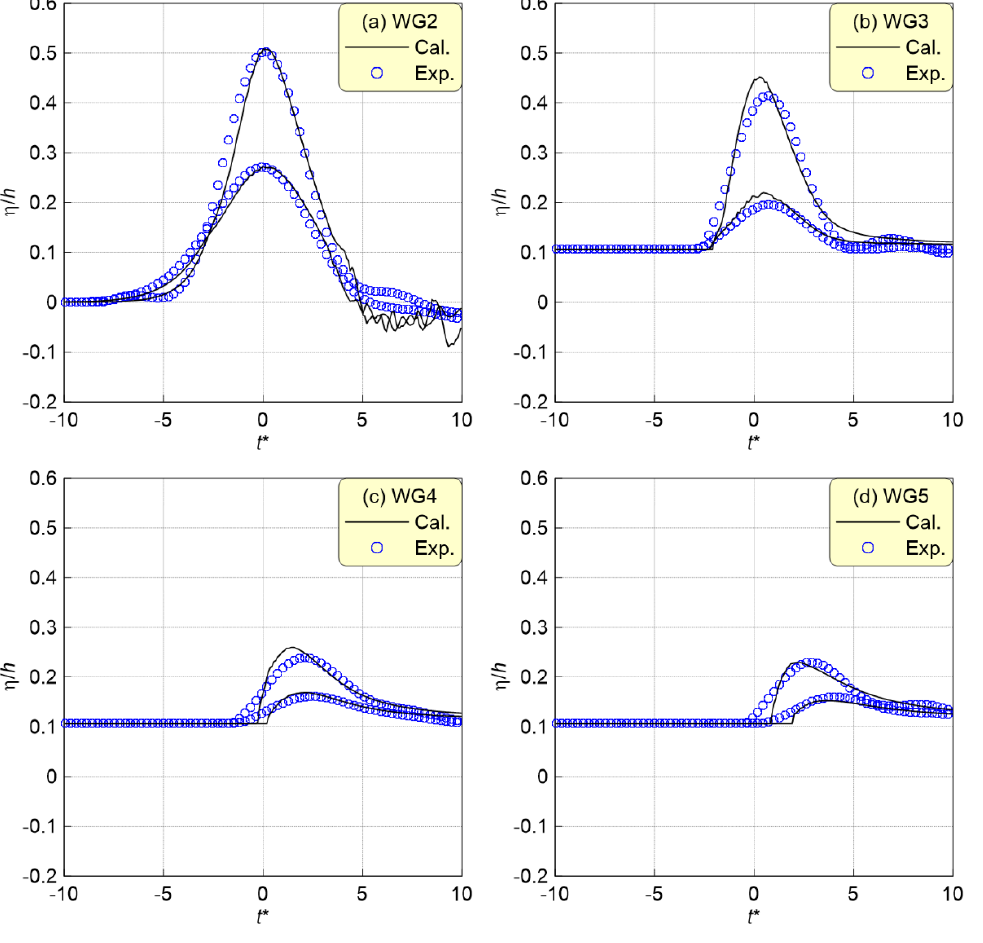
Figure 11. Comparisons of measured and calculated time-domain water surface elevations at the WAR. To evaluate the numerical accuracy of the NWT used in the solitary wave overtop- ping and inundation analysis according to the revetment type, this study used R-squared (R 2 ), mean square error (MSE), root mean square error (RMSE), and normalized root mean